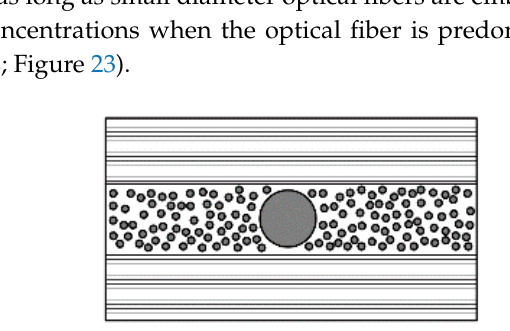
Figure 23. Optical fibers embedded parallel to the orientation of the reinforcement fibers can avoid fiber waviness as long as the diameter is small or the thickness of the composite layer is thick enough.